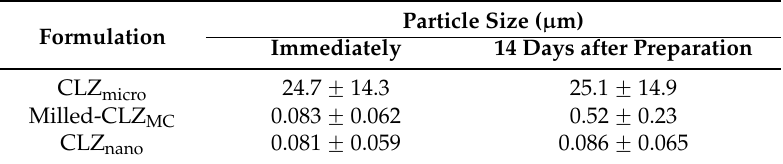
Table 2. Changes in CLZ particle size in CLZ dispersions 14 days after treatment with ball and bead mill.